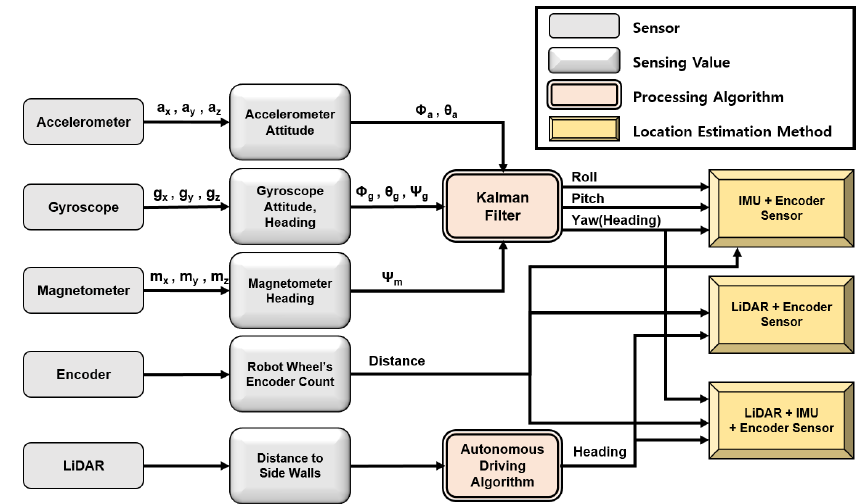
Figure 3. System architecture of the data processing procedure for the autonomous driving robot used in this study.